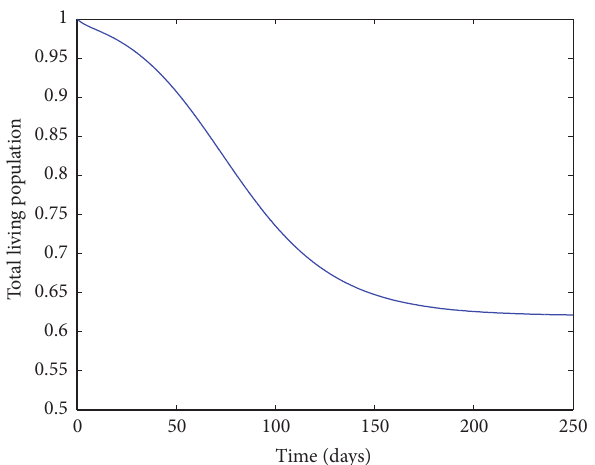
Figure 13: Evolution of the total alive population with daily culling rate of 𝜌 𝐷 = 0.1 and constant vaccination of 𝑉 = 𝑉 0 = 0.2𝑏 1 .